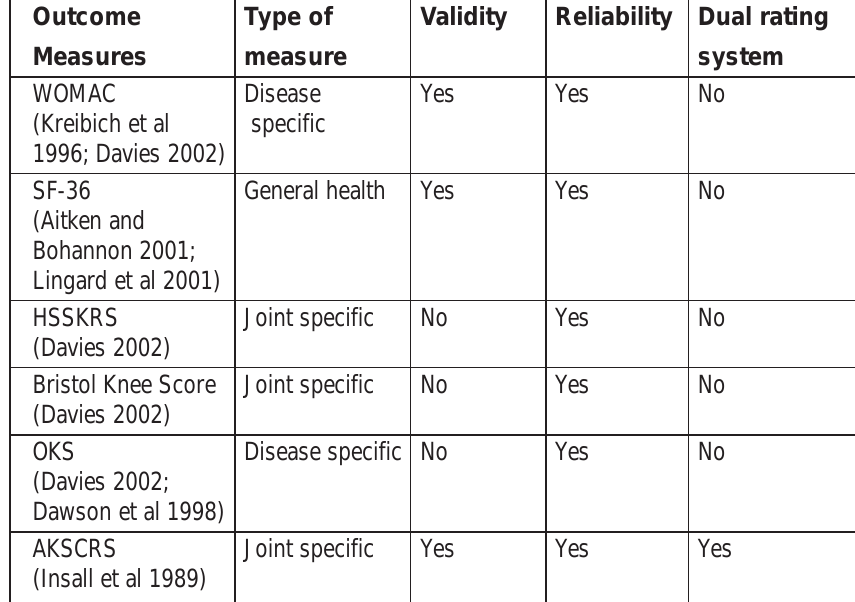
Table 1: Classification of outcome measures based on their type, validity, reliability and dual rating